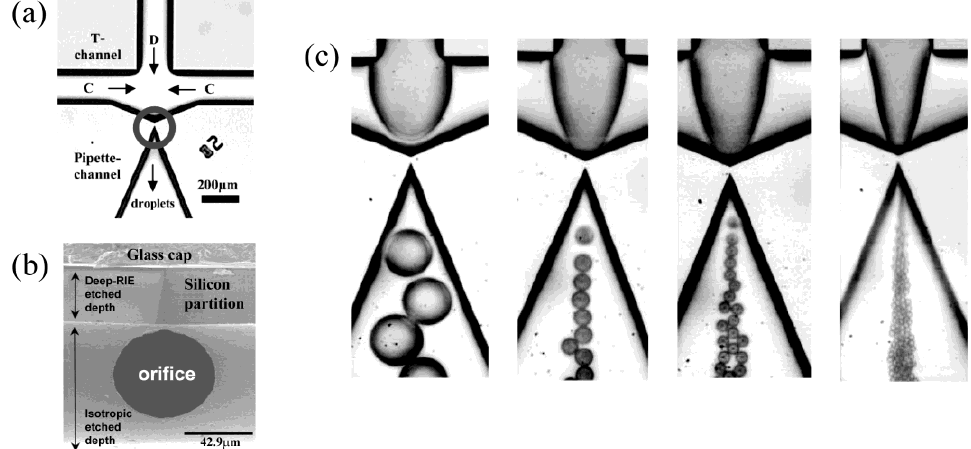
Figure 5. Axisymmetric flow focusing design: ( a ) planar view; ( b ) SEM image of the circular orifice; ( c ) water droplets formation at increasing oil flow rates and fixed water flow rate. Reprinted from [61] with permission from Royal Society of Chemistry